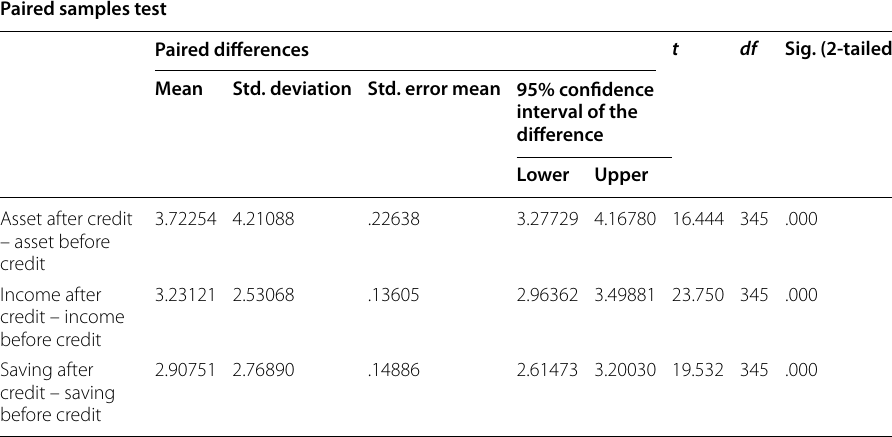
Table 2 Paired sample test results Paired samples test Paired differences t df